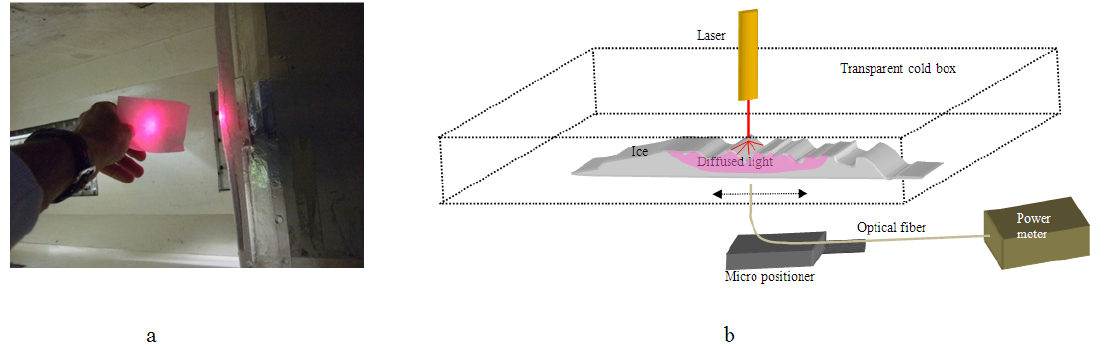
Figure 11. ( a ) Illumination through ice from inside the wing. ( b ) Schematic diagram of optical diffusion experimental set up using section of ice, taken at the end of icing runs, and measured in a cool box.